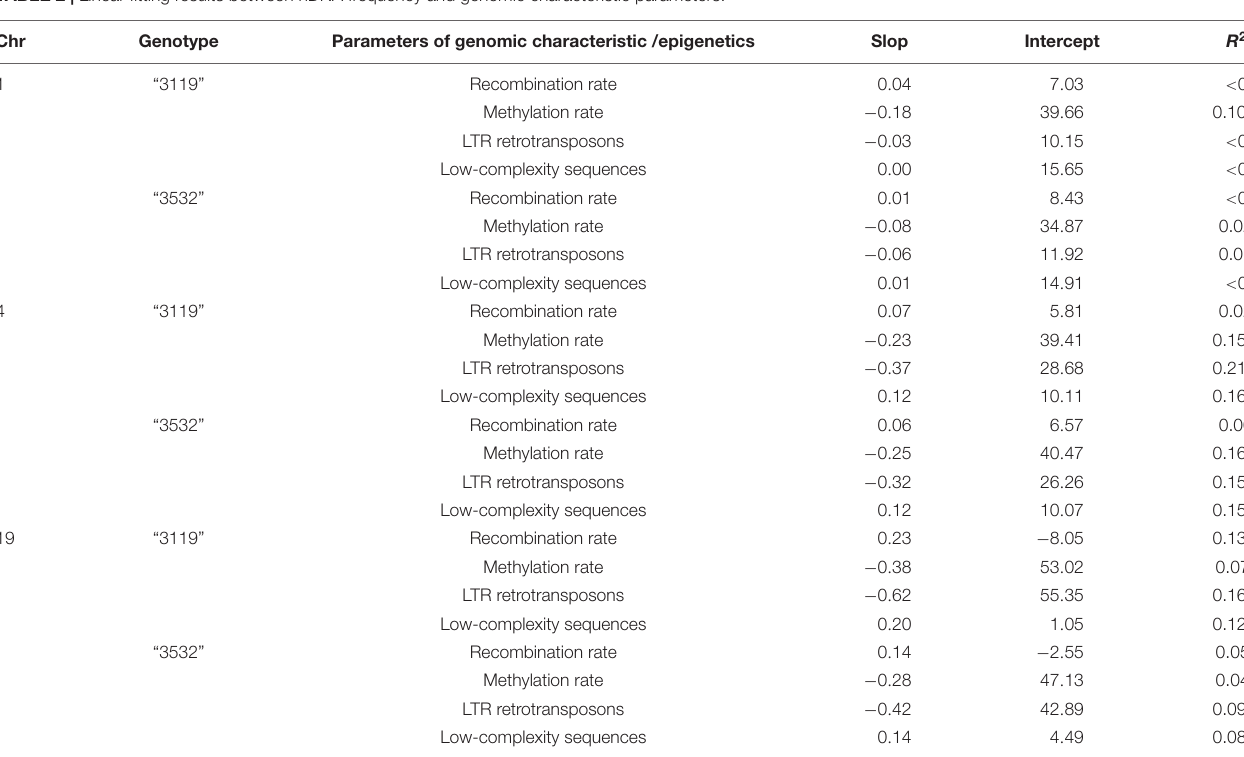
FIGURE 5 | Correlation analysis between hDNA frequency and the distance from the locus to the centromere on Chr01, 04 under multiple markers. TABLE 2 | Linear fitting results between hDNA frequency and genomic characteristic